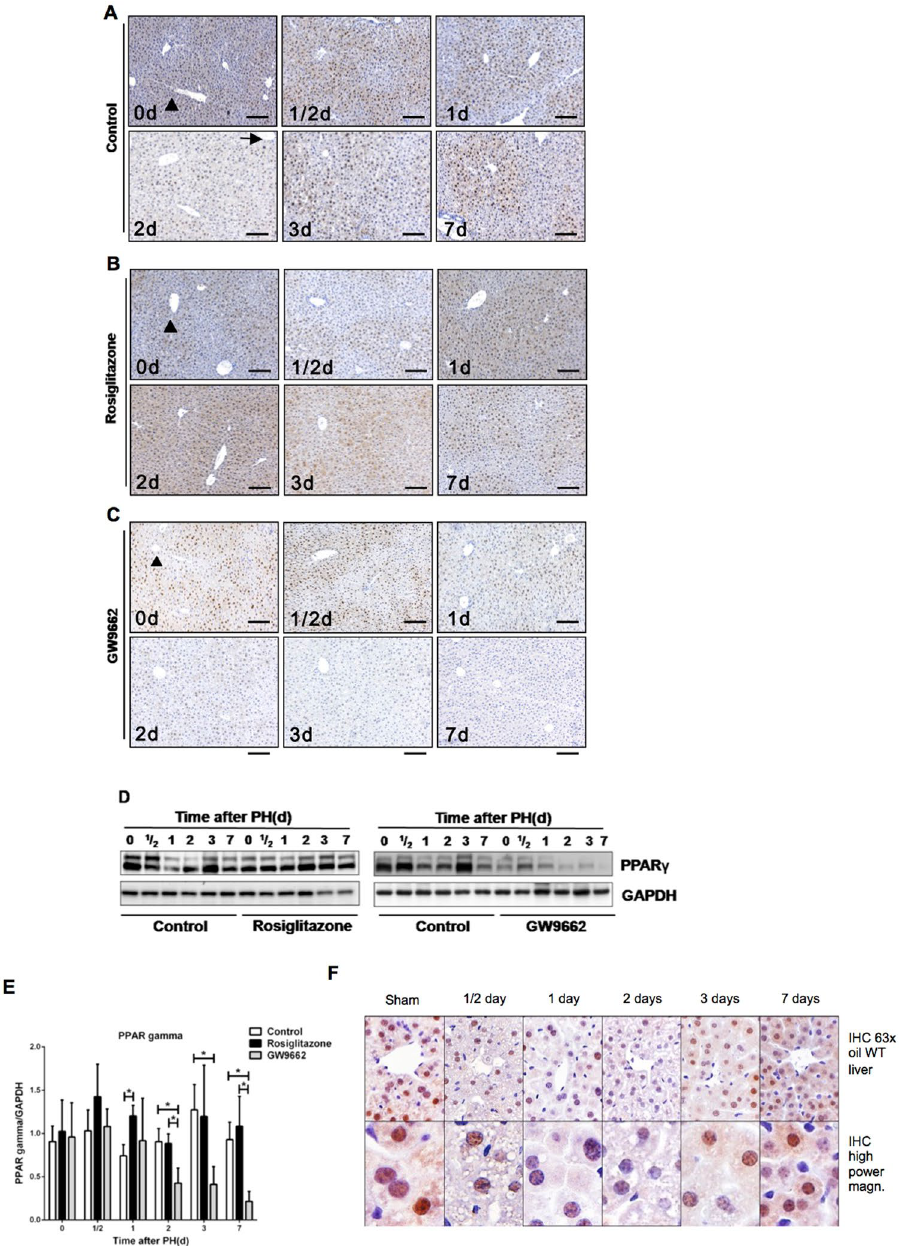
Figure 1. PPAR γ inhibits hepatocellular proliferation during mouse liver regeneration ( A ) Hepatic PPAR γ expression during mouse liver regeneration. Representative Immunohistochemistry (IHC) analysis for PPAR γ in untreated mice, ( B ) rosiglitazone-treated mice, and ( C ) GW9662-treated mice at different time points after PH. Scale bar: 200 μ m. Arrow: Centrilobular zone, Arrowhead: Periportal zone. ( D ) Hepatic expression of PPAR γ protein in control mice, rosiglitazone-treated mice and GW9662-treated mice at different time points after partial hepatectomy. ( E ) Quantification of Western blots after analysis of three biological triplicates. ( F ) Analysis of cellular localization of PPAR gamma at different time points after PH in wild type mice. * p <